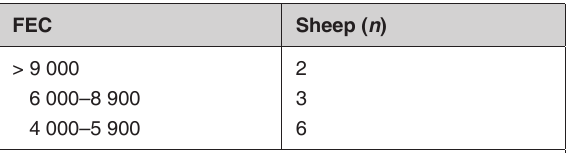
TABLE 8 Experiment 3 (Farm 2, young replacement ewes): Largest individual FECs (January and February)—